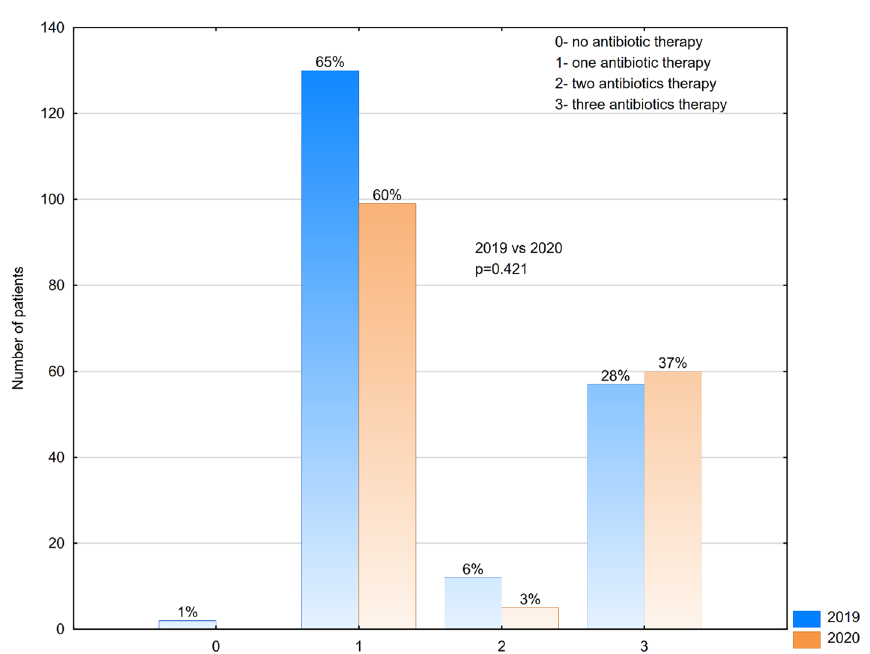
Figure 3. Antibiotic therapy among patients treated with appendectomy in 2019 and